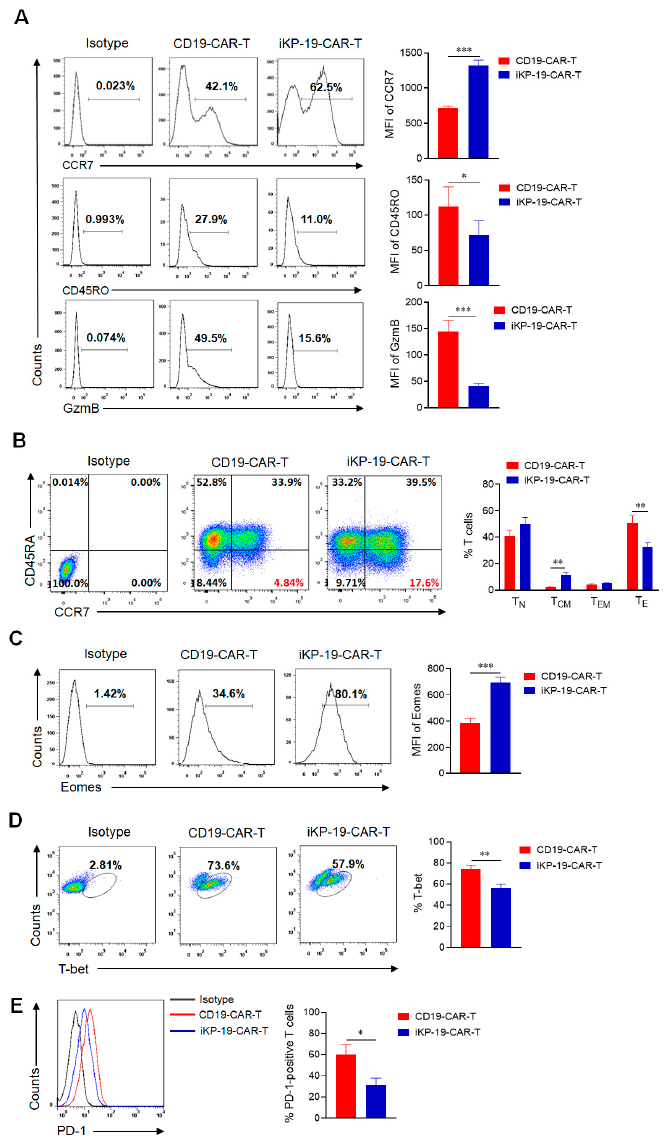
Figure 3. Characteristics of iKP-19-CAR-T cells and CD19-CAR-T cells. iKP-19-CAR-T cells or CD19- CAR-T cells were cultured for 10 days in X-VIVO media supplemented with 100 U/mL IL-2. ( A ) The expression of T cell differentiation markers in CAR-T cells was analyzed by flow cytometry using PE/Cy7-anti-human CCR7 antibody, PE-anti-human-CD45RO antibody and PE-anti-human GzmB antibody ( n = 4 different donors). ( B ) The frequency of naïve (T N ; CCR7 + CD45RA + ), T CM (CCR7 + CD45RA − ), effector memory (T EM ; CCR7 − CD45RA − ) or effector (T E ; CCR7 − CD45RA + ) T cells were analyzed by flow cytometry using PE/Cy7-anti-human CCR7 antibody and FITC-anti-human CD45RA antibody ( n = 4 different donors). ( C ) The expression of transcription factor Eomes in CAR- T cells was analyzed by flow cytometry using FITC-anti-human Eomes antibody ( n = 4 different donors). ( D ) The expression of transcription factor T-bet in CAR-T cells was analyzed by flow cytometry using PE-anti-human T-bet antibody ( n = 4 different donors). ( E ) The expression of T cell exhaustion marker PD-1 in CAR-T cells was analyzed by flow cytometry using FITC-anti-human PD- 1 antibody ( n = 4 different donors). All experiments were performed in triplicate manner using PBMCs from each donor and MFI or percentage was statistically analyzed. ** p < 0.01, *** p < 0.001. Error bars represent ± SD.